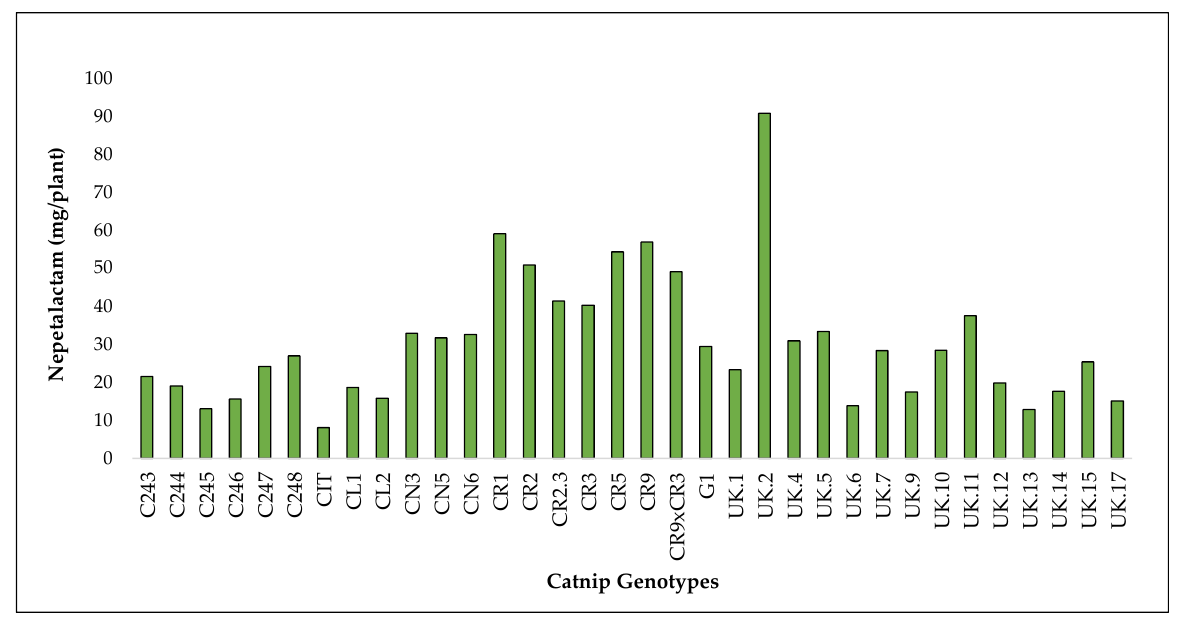
Figure 7. Accumulated yield of nepetalactam in catnip genotypes after 3 successive harvests (2017 1 and 2 and 2018). Pittstown, NJ, USA. In 2017, UK.9 had the lowest Dihydronepetalactone (DHNL) content at 4.2 mg/plant while CR5 had the highest at 15.8 mg/plant. In 2018, CL2 had the lowest DHNL at 1.0 mg/plant while CR5 had the highest DHNL at 11.6 mg/plant. (Figure 8, Table S5).